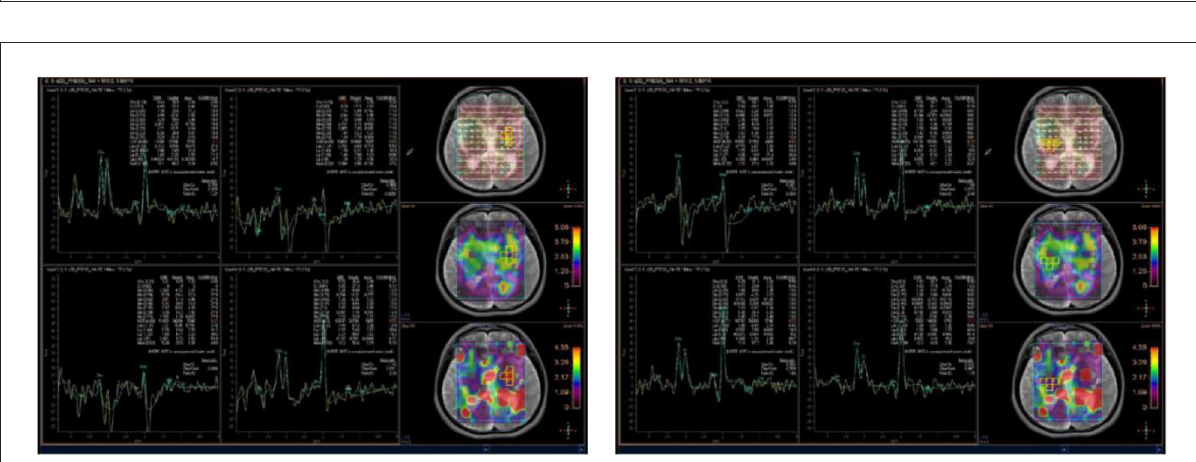
FIGURE6 Brain magnetic resonance spectroscopy (MRS) showed an increased peak of choline, a decreased peak of N-acetylaspartate, and an inverted peak of lipid-lactate around bilateral basal